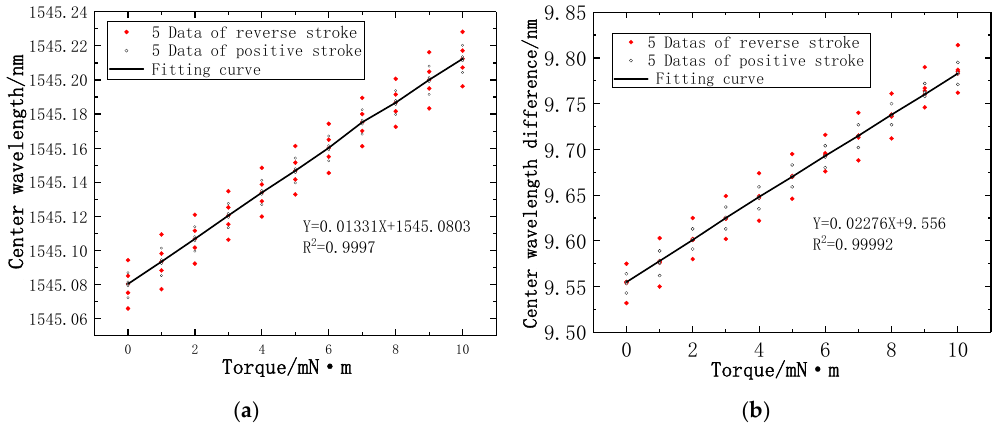
Figure 12. Wavelength and torque relation curves of two FBGs: ( a ) Center wavelength fitting curve of FBG1; ( b ) Fitting curve of central wavelength difference between FBG1 and FBG2. In the axial force calibration experiments, the axial force calibration range is 5 N. In the same way, five datapoints are recorded for the axial force gradient of positive and reverse stroke, respectively. A total of 10 data are recorded at each axial force gradient. There is a linear relationship between the Bragg wavelength measured by the axial force FBG3 sensor and the axial force gradient, as presented in Figure 13a. It can be seen from the slope of the fitting curve that the axial force strain sensitivity is 0.071 nm/N and the determination coefficient R 2 of the FBG3 sensor is 0.9996. Figure 13b illustrates the difference of Bragg wavelength between axial force FBG3 sensor and reference FBG2 sensor has a linear relationship with axial force gradient, which leads to that the axial force strain sensitivity is increased to 0.089 nm/N, and the determination coefficient R 2 is 0.9997.